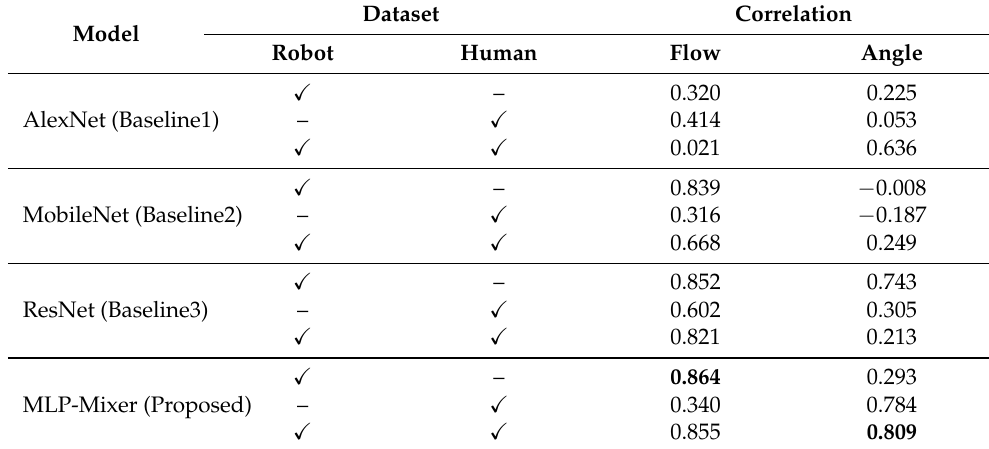
Table 2. Spearman’s rank correlation coefficients for different models and datasets.